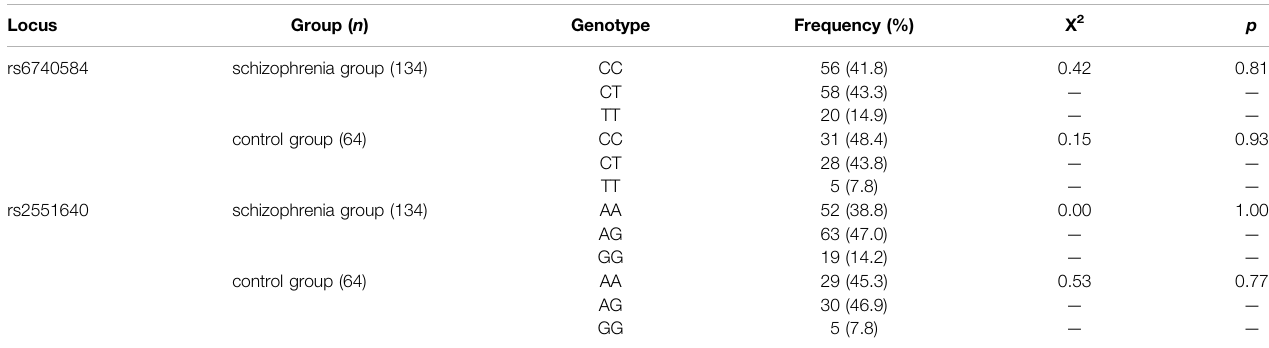
TABLE 2 | Hardy – Weinberg equilibrium test for CREB genotypes. Locus